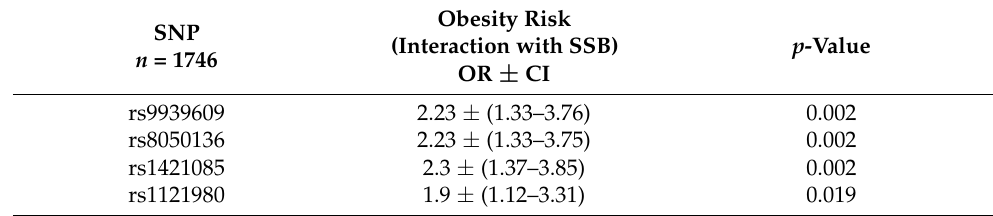
Table 6. Interaction between SSBs consumption and FTO SNPs on obesity risk (BMI > 30) in women. SNP n = 1746